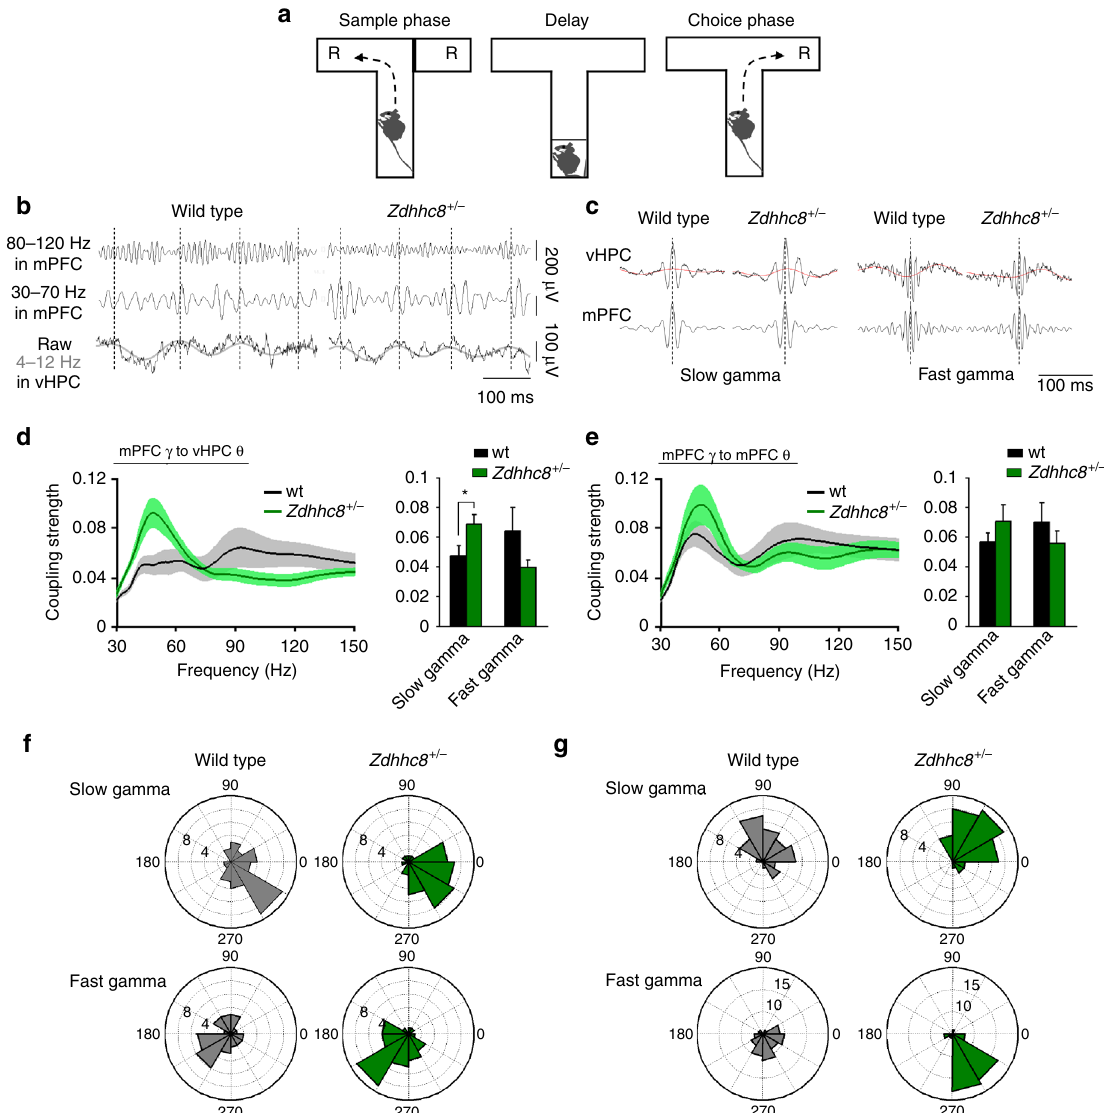
Fig. 2 Theta – slow gamma coupling between vHPC and mPFC is augmented in Zdhhc8 + / − mice. a Delayed non match to sample T-maze task. Each trial of the task comprised a sample phase and choice phase separated by 10 s delay. R: reward. The mouse images were created by the authors. b Example traces of fast gamma- and slow gamma-range fi ltered local fi eld potentials in the mPFC and theta-ranged fi ltered local fi eld potentials in the vHPC. Left: wild type. Right: Zdhhc8 + / − . c Averaged raw (black) and theta-range fi ltered (red) traces in the vHPC (top) obtained by aligning the signals at the peak of slow (left) and fast (right) gamma oscillations in the mPFC (bottom). d Left: strength of vHPC theta modulation of mPFC gamma as a function of power frequency in the mPFC. Right: averaged theta-gamma coupling in the slow gamma – range (theta – slow gamma coupling) and fast gamma range (theta – fast gamma coupling), demonstrating signi fi cantly higher theta – slow gamma coupling in Zdhhc8 + / − mice. On the other hand, this mutant showed weaker vHPC theta- mPFC fast gamma coupling, though it did not reach statistical signi fi cance (slow gamma; p = 0.044, fast gamma; p = 0.14). * p < 0.05. Student ’ s t -test. n = 8 wild-type (wt) and n = 9 Zdhhc8 + / − mice. e Left: strength of coupling of mPFC gamma with local mPFC theta as a function of power frequency in the mPFC. Right: averaged theta – gamma coupling in the slow and fast gamma range. Theta – gamma coupling did not differ by genotype (slow gamma; p = 0.29, fast gamma; p = 0.35). Student ’ s t -test. f , g Distribution of the mean direction of gamma power in the mPFC for the theta cycle phase in the vHPC ( f ) and mPFC ( g ) for 32 recordings from 8 wild type and 33 recordings from 9 Zdhhc8 + / − mice. Mean direction did not signi fi cantly differ by genotype regardless of gamma range (slow gamma to vHPC theta; p = 0.98, fast gamma to vHPC theta; p = 0.12, slow gamma to mPFC theta; p = 0.11, fast gamma to mPFC theta; p = 0.85). Watson – Williams